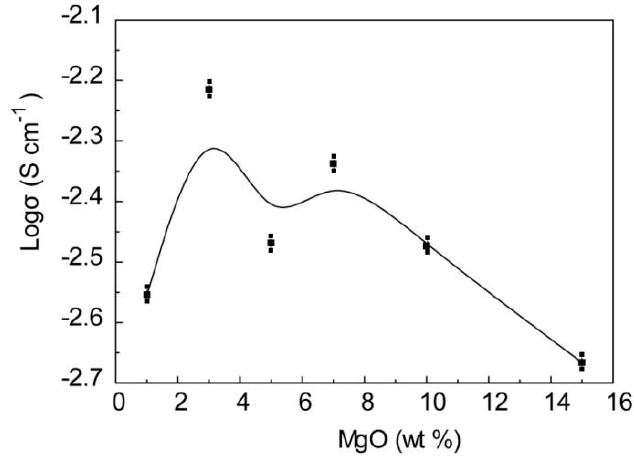
Figure 6. The variation of room-temperature conductivity of the GPEs with different contents of nano-MgO.